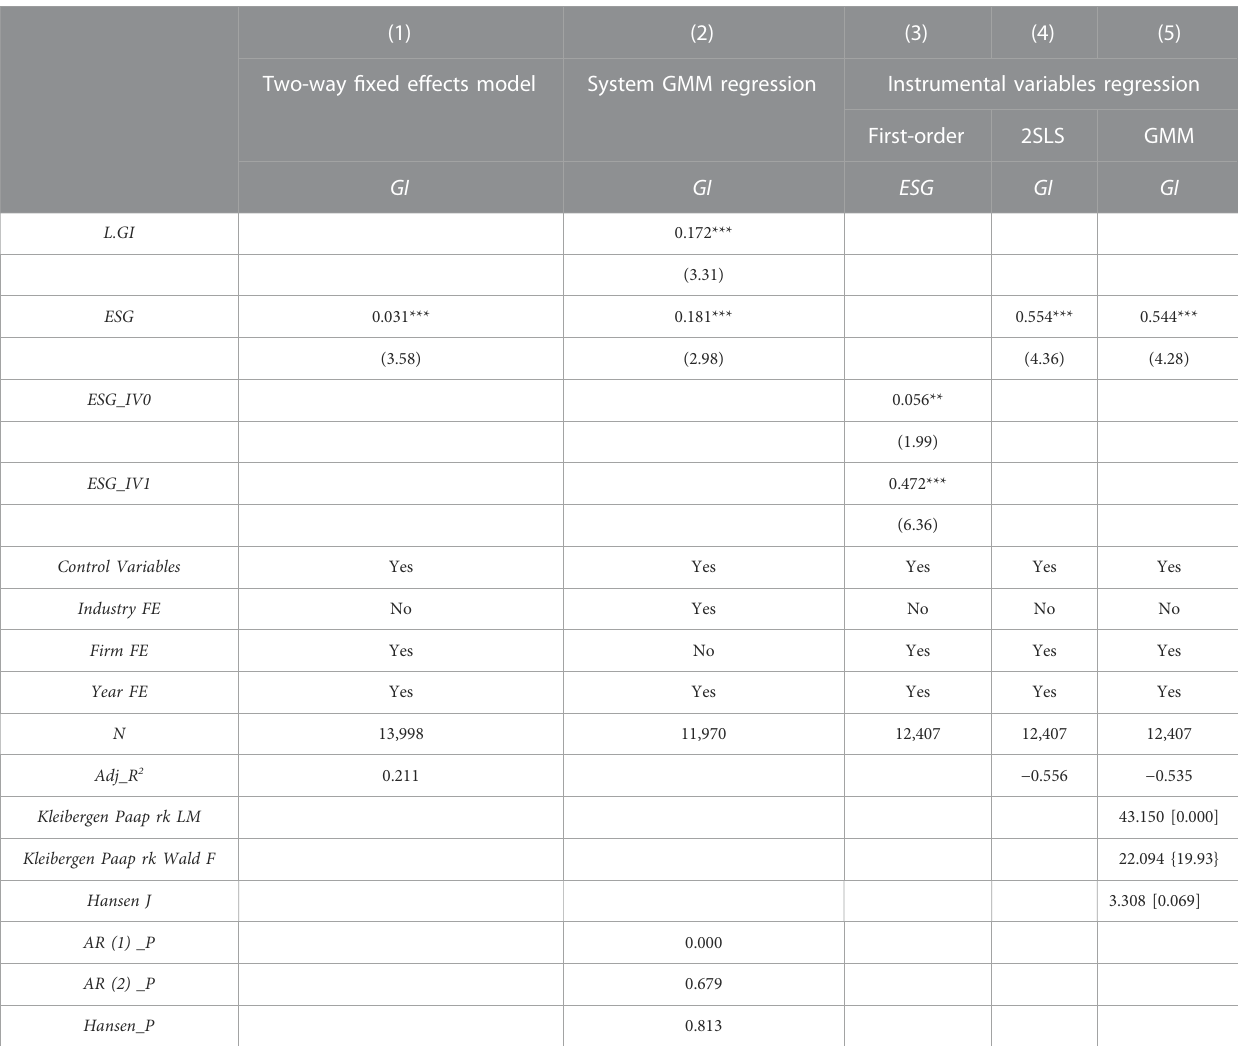
TABLE 5 Regression results dealing with endogeneity.